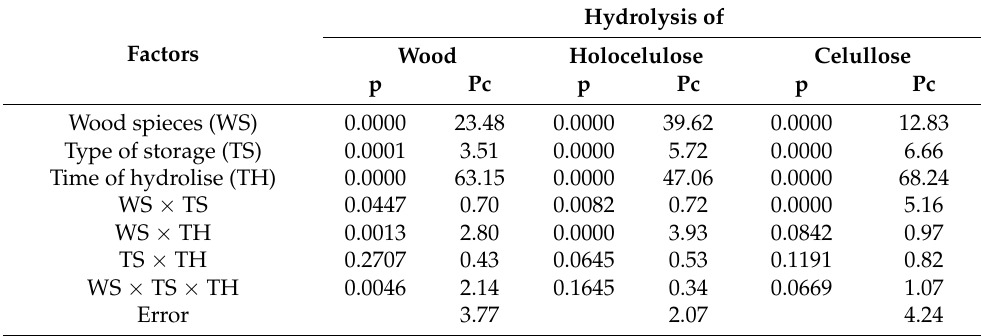
Table 2. Analysis of variance of the studied factors affecting hydrolysis efficiency. Factors